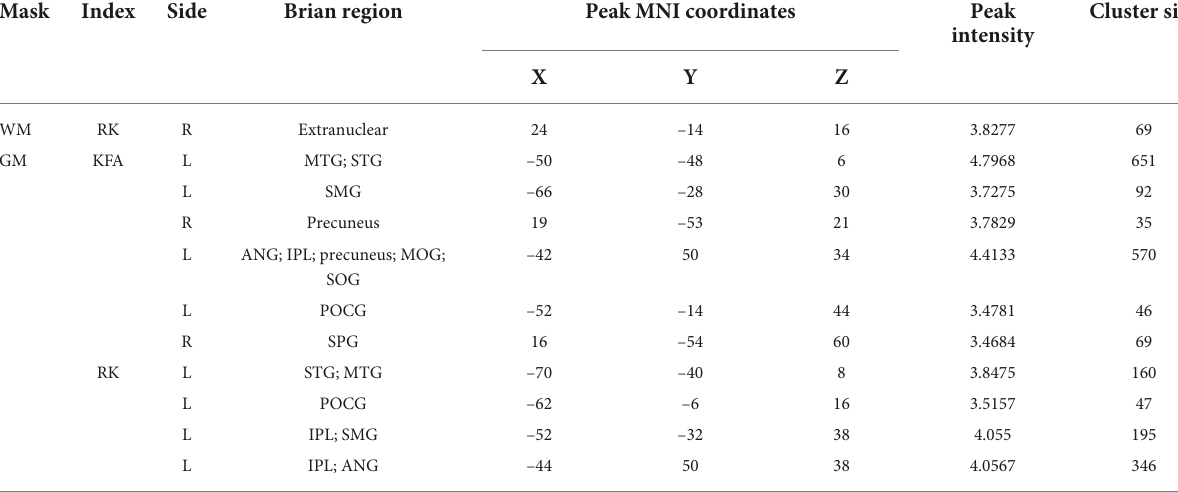
TABLE 2 Brain regions of anti-NMDAR encephalitis patients showed significant microstructural